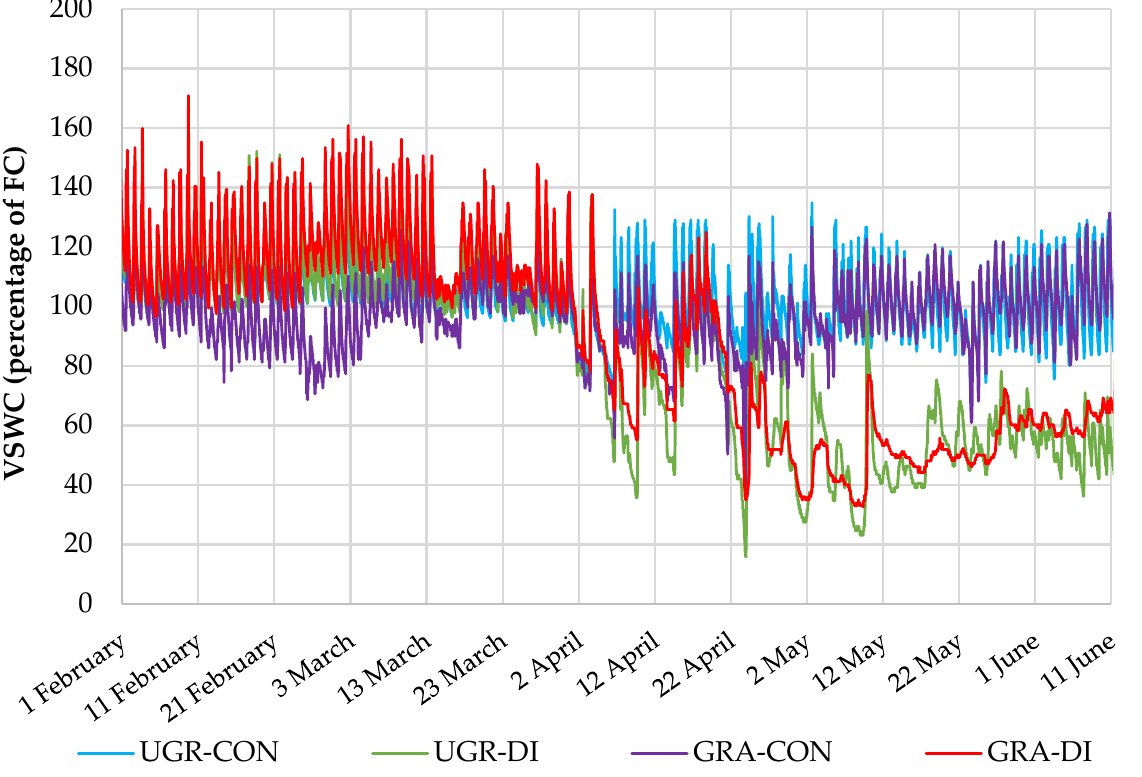
Figure 1. Volumetric soil water content (VSWC) expressed as a percentage of field capacity (FC) for the substrate corresponding to the grafting factor, grafted (GRA) and ungrafted (UGR), and for both water stress levels: control (CON) and deficit irrigation (DI).